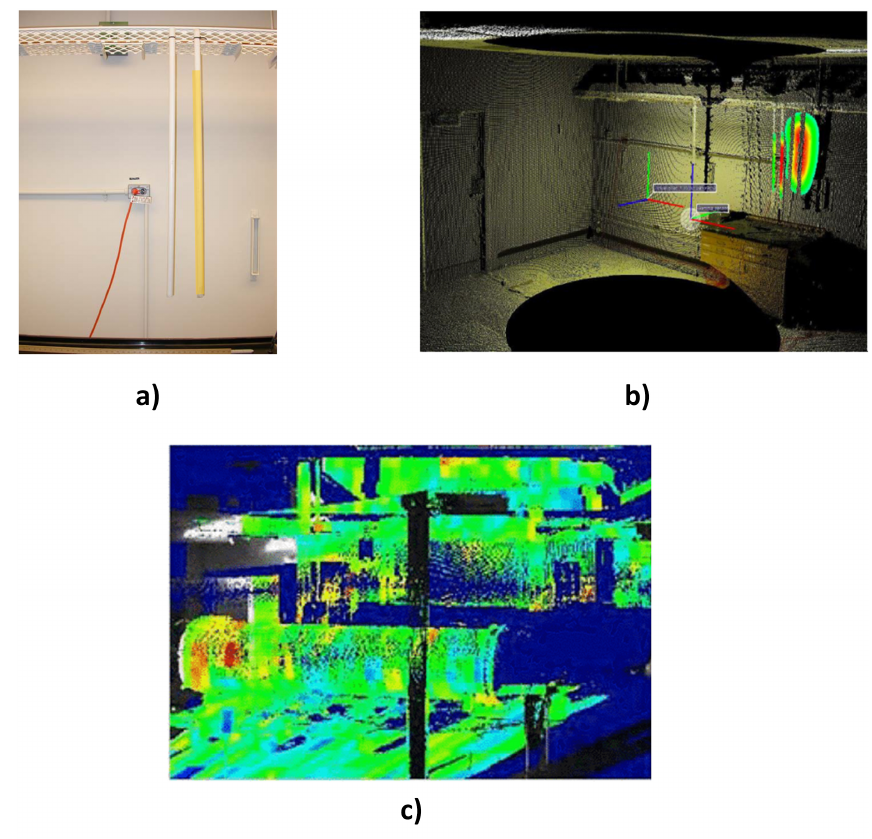
Figure 2. ( a ) Zoomed-in picture of the experimental contaminated environment. The contaminated pipe is indicated in yellow colour [17]. ( b ) Gamma image projected into the 3D LiDAR image of the scene in (a) [17]. ( c ) Gamma image projected into the 3D LiDAR image of another contaminated environment described in